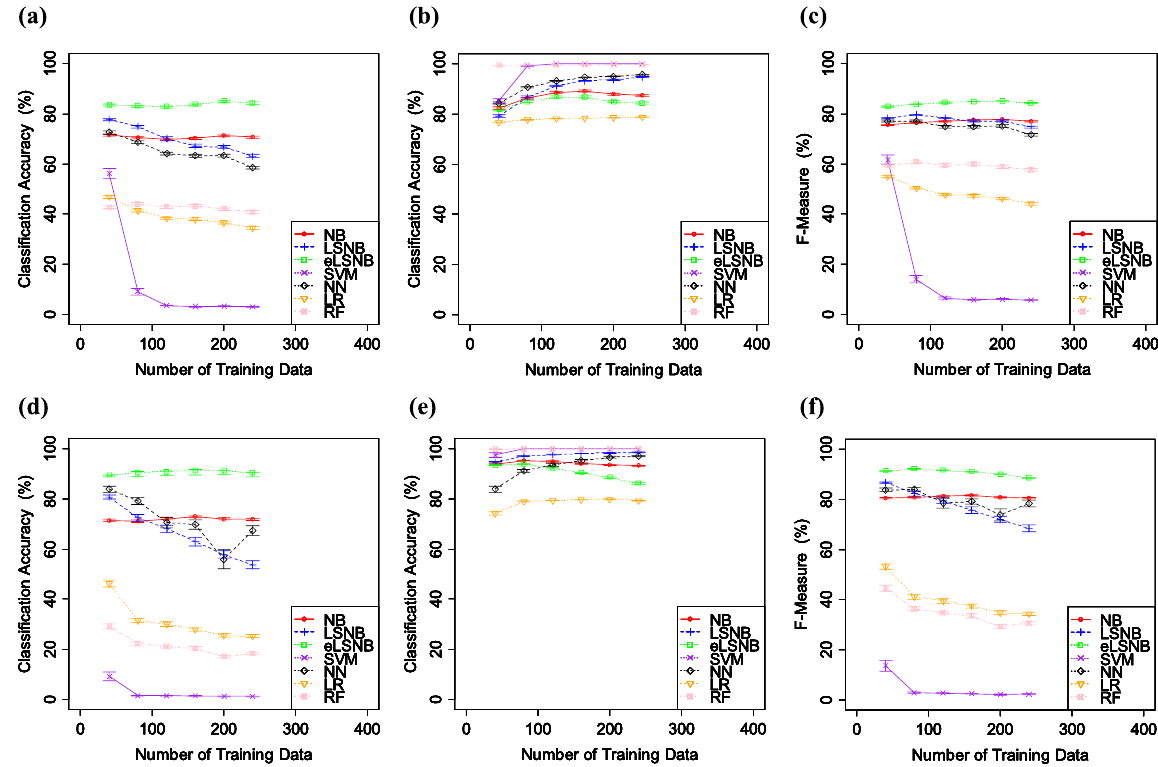
Figure 6. ( a ) spam classification accuracy, ( b ) ham classification accuracy and ( c ) F-measure values for SpamAssassin. ( d ) spam classification accuracy, ( e ) ham classification accuracy and ( f ) F-measure values for Ling-Spam. The number of spam training data points was predefined to 25. Error bars indicate the standard